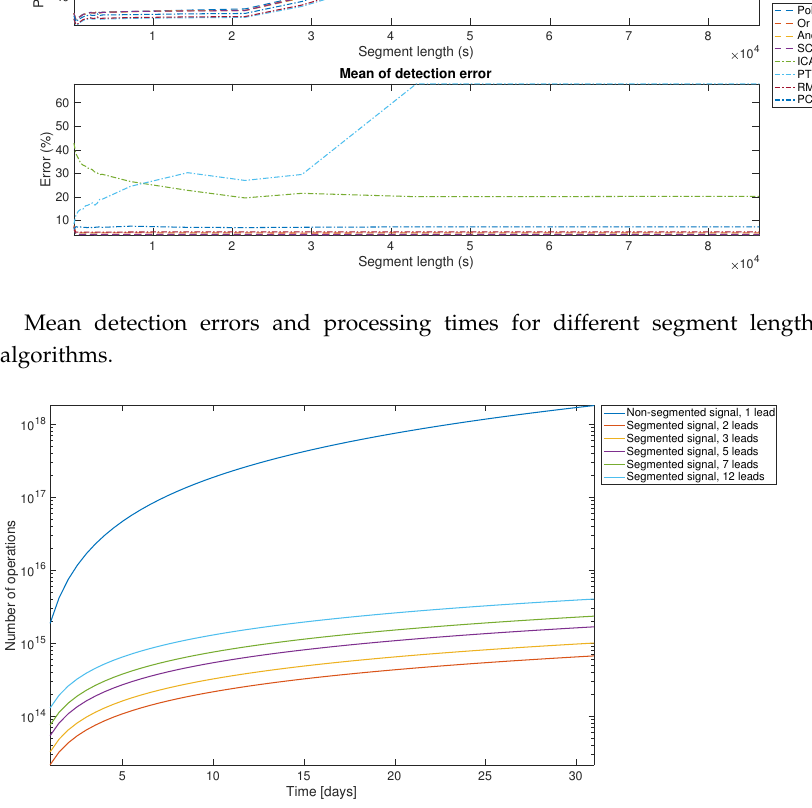
Figure 6. Estimated computational complexity in terms of the number of operations per recording and of its duration (from 1 to 31 days), and for different number of leads. The dark blue line represents the number of operations of a complete single-lead signal, and the others show different lead configurations when including the segmentation